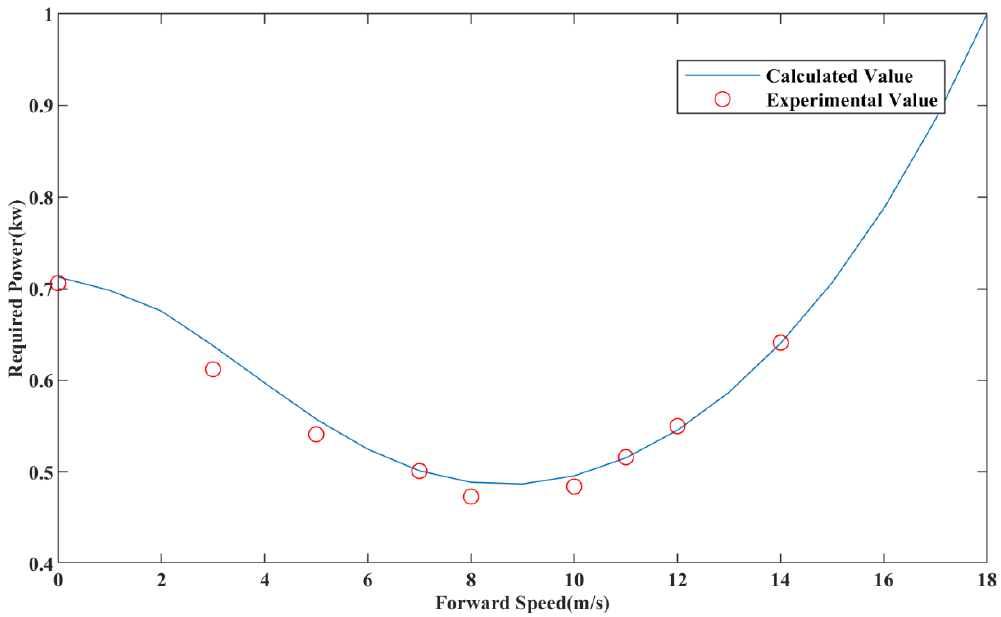
Figure 3. Variation of the calculated required power of trim with the increasing forward flight speed (calculated value) compared to the actual required power of the verification aircraft (experimental value).